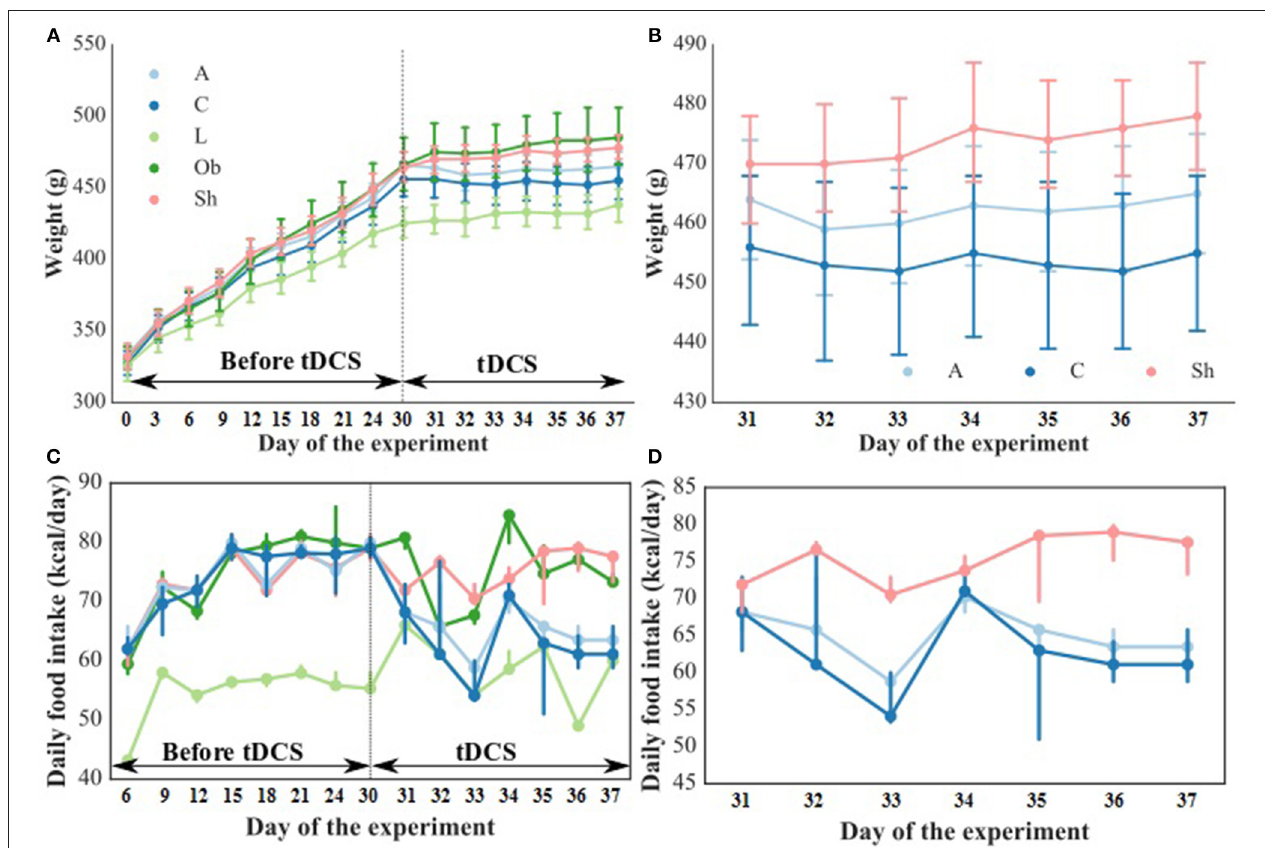
FIGURE 1 | Body weight [g] during the entire experiment (A) and during tDCS application (B) as well as food intake [kcal/day] during the entire experiment (C) and during tDCS application (D) . The dashed line indicates the start of tDCS treatment. L, lean intact ( n = 11); Ob, obese intact ( n = 10); Sh, obese with sham stimulation ( n = 11), A, obese with anodal stimulation of the right prefrontal cortex ( n = 14); C, obese with cathodal stimulation of the left prefrontal cortex ( n = 11). Data are presented as the mean ± SD and median (25–75th percentile). Repeated measures ANOVA with the Tukey post-hoc test (body weight) or repeated measures nonparametric ANOVA (food intake) was